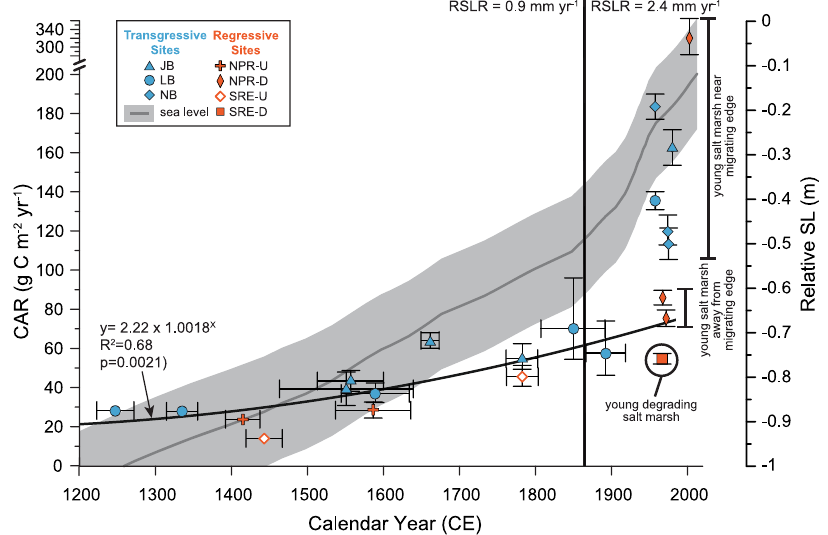
Fig. 4 Carbon accumulation rates (CAR) of transgressive and regressive salt marshes increase with decreasing age of initial colonization. At the end of the 19th century, relative sea-level rise (RSLR) accelerated to ∼ 2.4 mm yr − 1 (grey line ±95% con fi dence interval) 38 and promoted higher rates of salt marsh vertical accretion and CAR over the last 120 years than previous centuries. The CAR of young salt marsh (<120 years) measured near migrating edges is high and variable due to the greater accommodation from subsidence and water depth at landward and basinward margins, respectively, that promoted rapid accumulation of carbon-rich sediment 35 . Each point on the graph represents an individual core. The exponential curve is based on the samples younger than 1900 CE. Symbols are plotted at the median calibrated age and error bars represent 95% con fi dence intervals (error bars <symbol size not displayed). Study sites are differentiated by symbols with JB Jones Bay, LB Long Bay, NB Nelson Bay, NPR-U Newport River upstream, NPR-D Newport River downstream, SRE-U Shallotte River Estuary upstream, and SRE-D Shallotte River Estuary downstream. See Fig. 2, Table 1, and Supplementary Data 1 for additional